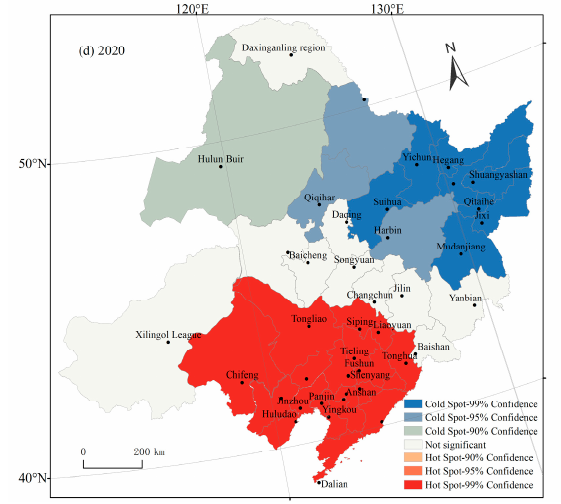
Figure 7. Interannual evolution of the spatial concentrations of O 3 from 2017 to 2020 in Northeast China.